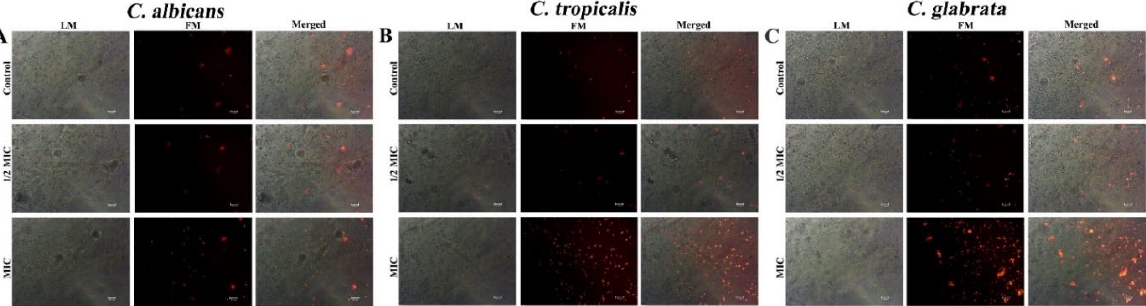
Figure 5. Cell membrane integrity of fungal strains such as ( A ) C. albicans , ( B ) C. tropicalis and ( C ) C. glabrata was assessed by PI staining after 30 min treatment with CTAC at 1/2MIC and MIC. LM—light microscopic images; FM—florescence micrograph; merged—merged fluorescence and light micrograph. Magnification—200×; scale bar—50 μ m.